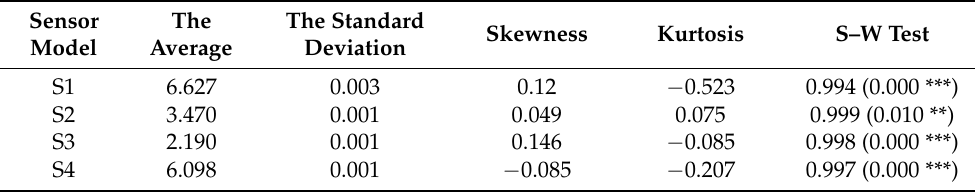
Table 1. Sensor output distribution table.